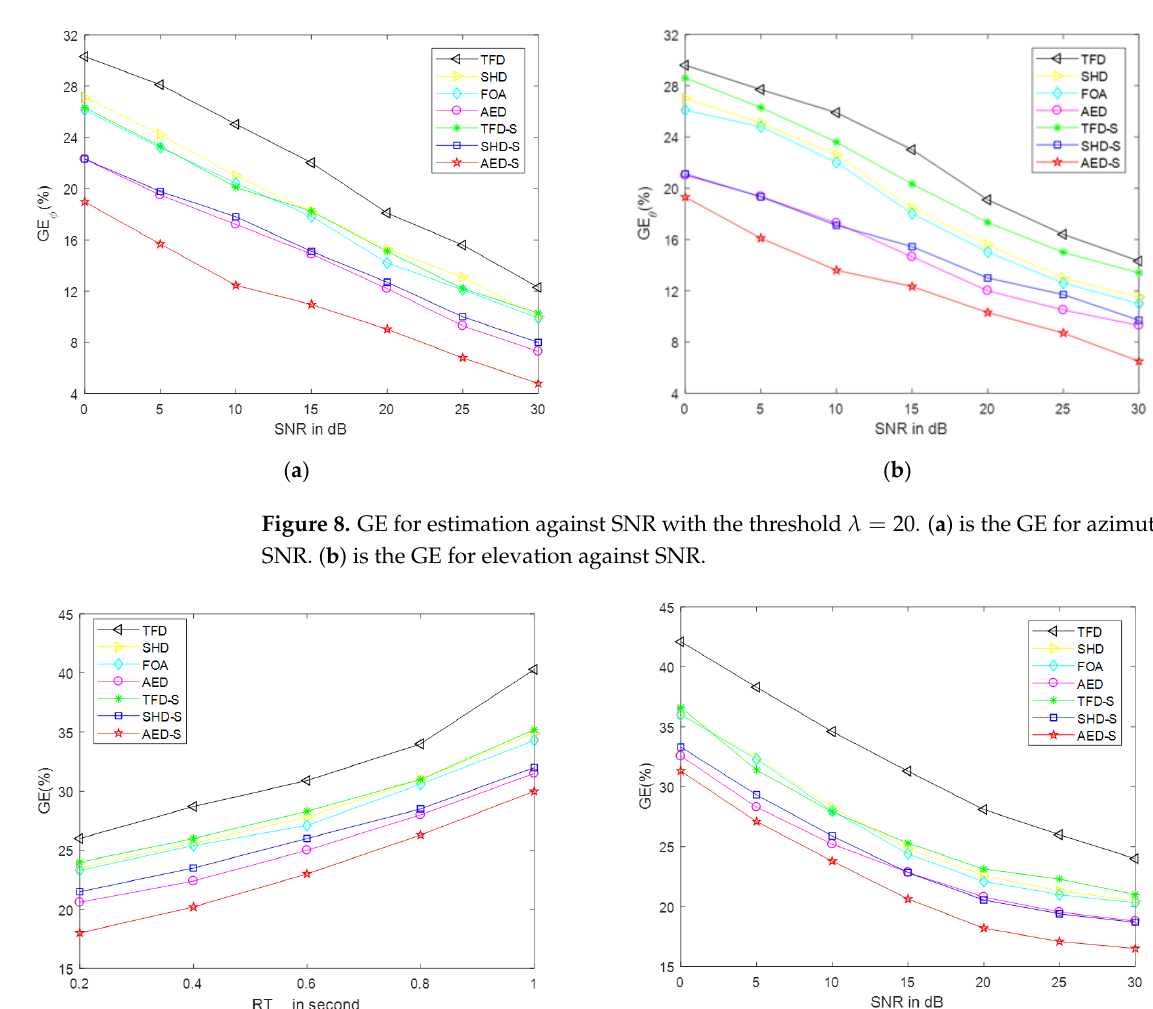
Figure 9. GE for estimation with the threshold λ = 10. ( a ) is the GE against RT 60 . ( b ) is the GE